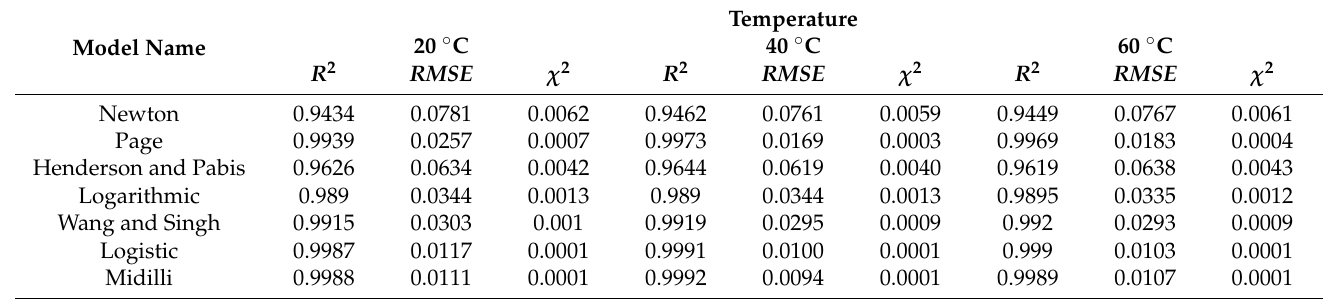
Table 3. Statistical analysis of models describing kinetics of freeze-drying of strawberry pulp.